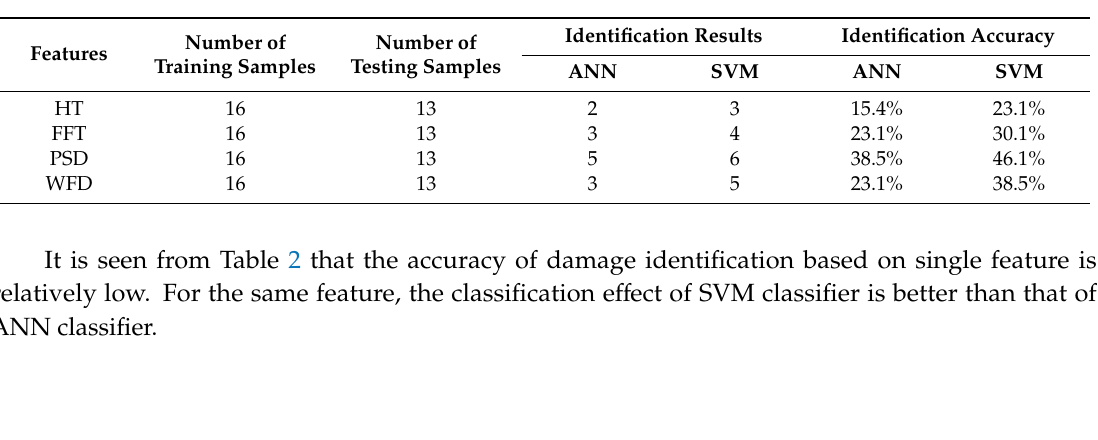
Table 2. Damage identification results based on single